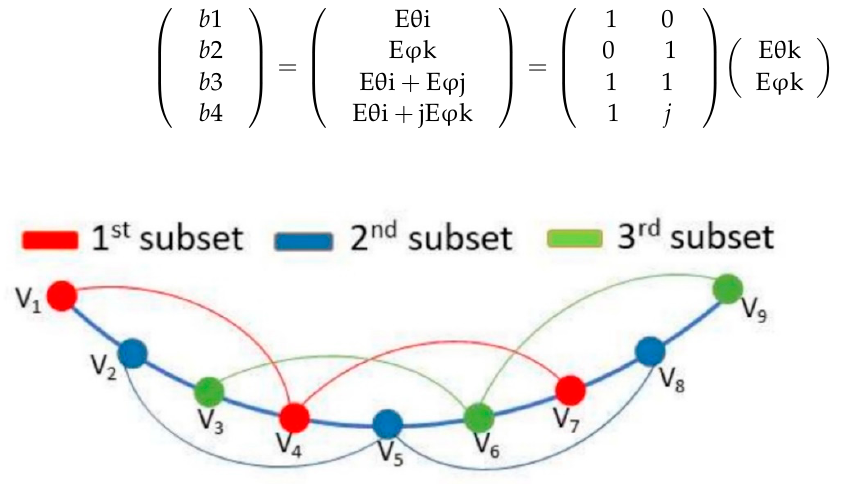
Figure 3. Signals combination for oversampling equal to 3, one azimuth cut.